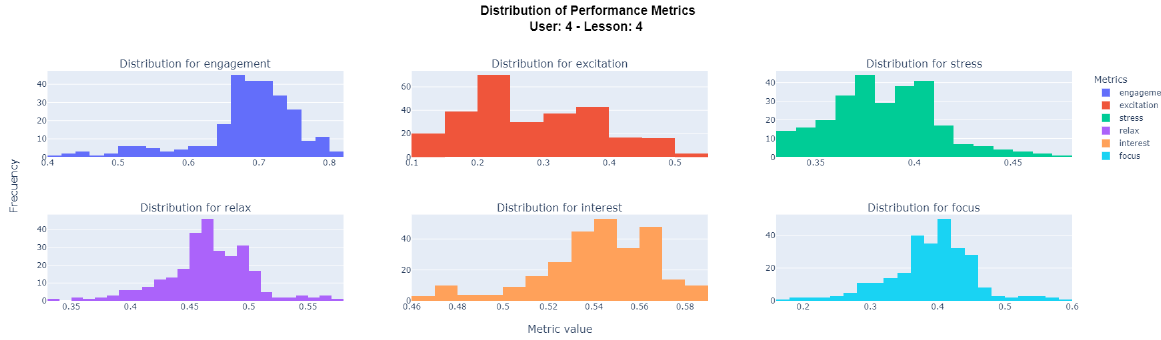
Figure 14. Distribution of performance metrics.